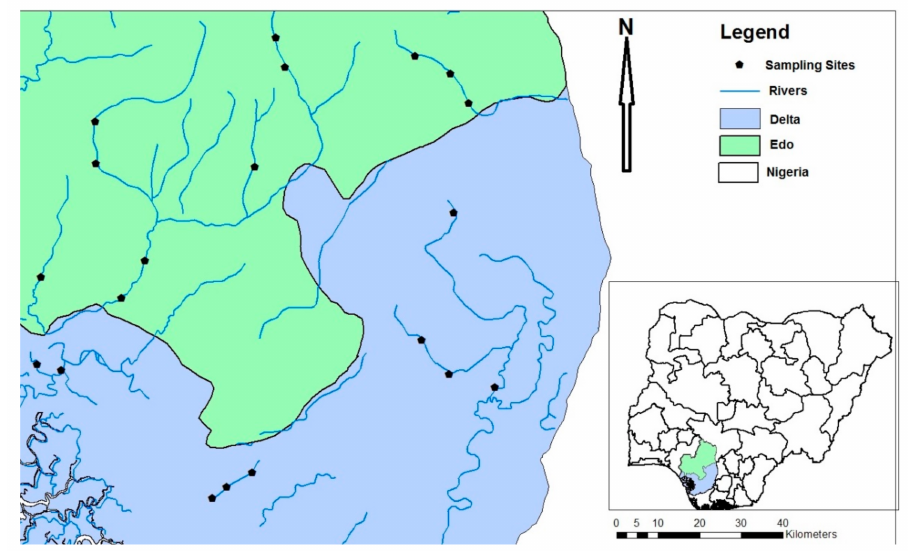
Figure 1. Study area map showing the sampling sites and the map of Nigeria, indicating the location of study area within the southern part of